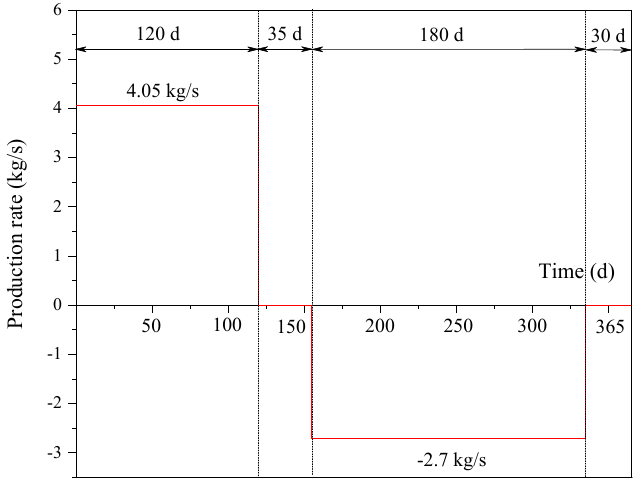
Figure 3. Production and injection rate in a one-year cycle.